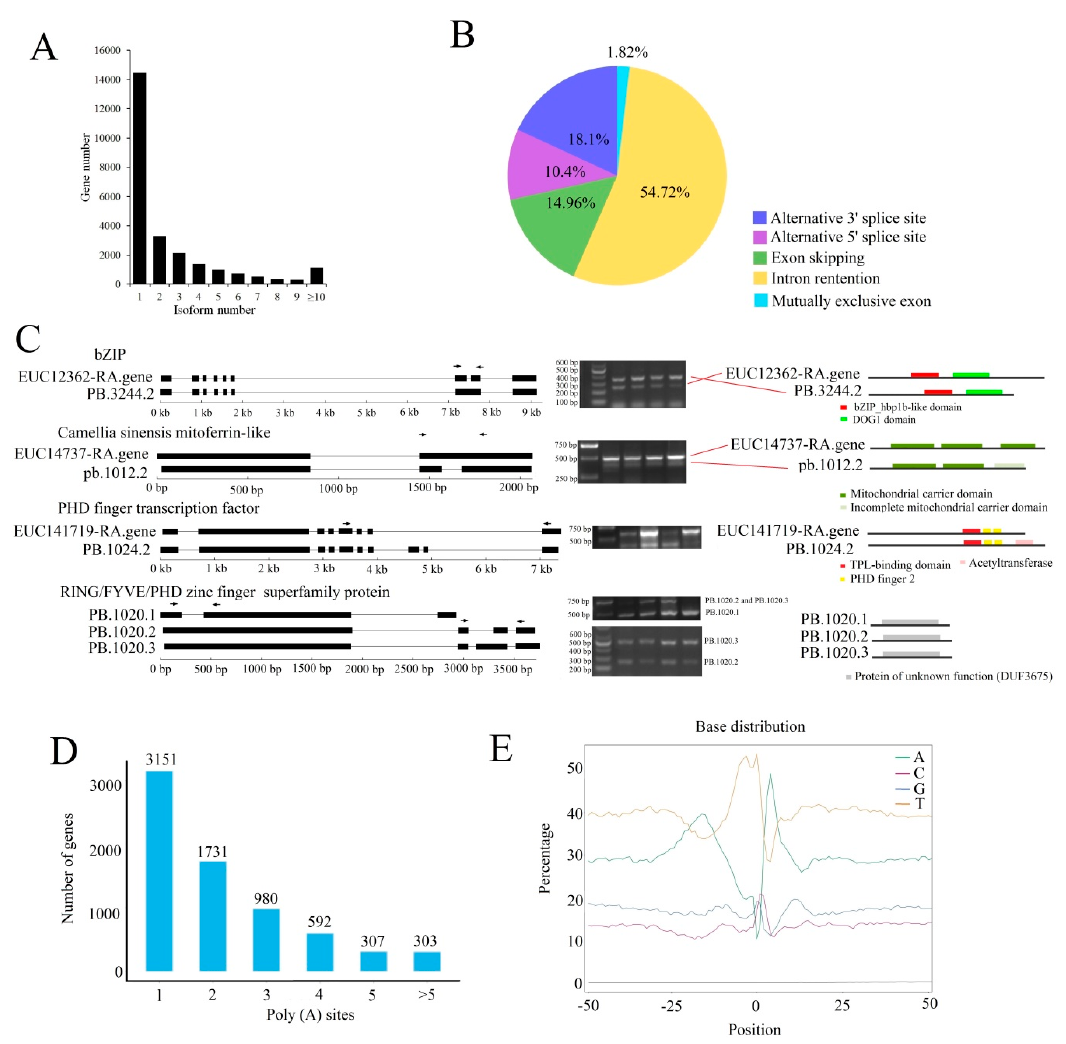
Figure 2. Characterization of Eucommia ulmoides leaf transcriptomes using isoform sequencing and second-generation sequencing (SGS). ( A ) Distribution of the number of isoforms per gene. ( B ) Distribution of di ff erent type of alternative splicing (AS) events in E. ulmoides . ( C ) PCR (Polymerase Chain Reaction) validation of alternative splicing events identified by Iso-Seq. The isoform model for each genes were shown on left panel. Gene models obtained from E. ulmoides genome database were shown on top and the novel isoforms that are supported by PacBio reads are shown under the gene. Black boxes represent for exons, lines represent introns, and arrows indicate primer sets (F, forward and R, reverse). Middle panel presented the validation of di ff erential AS (Alternative splicing) events using RT-PCR (Reverse Transcription-Polymerase Chain Reaction). Predicted protein sequence for each isoform and conserved domains predicted using the CD-search program (NCBI, National Center for Biotechnology Information) are presented in the right panel. ( D ) Distribution of the poly (A) site per gene. ( E ) Relative frequency of each nucleotide around poly(A) cleavage sites. Sequences in the upstream ( − 50 bp) and downstream ( + 50 bp) of each poly(A) cleavage site were